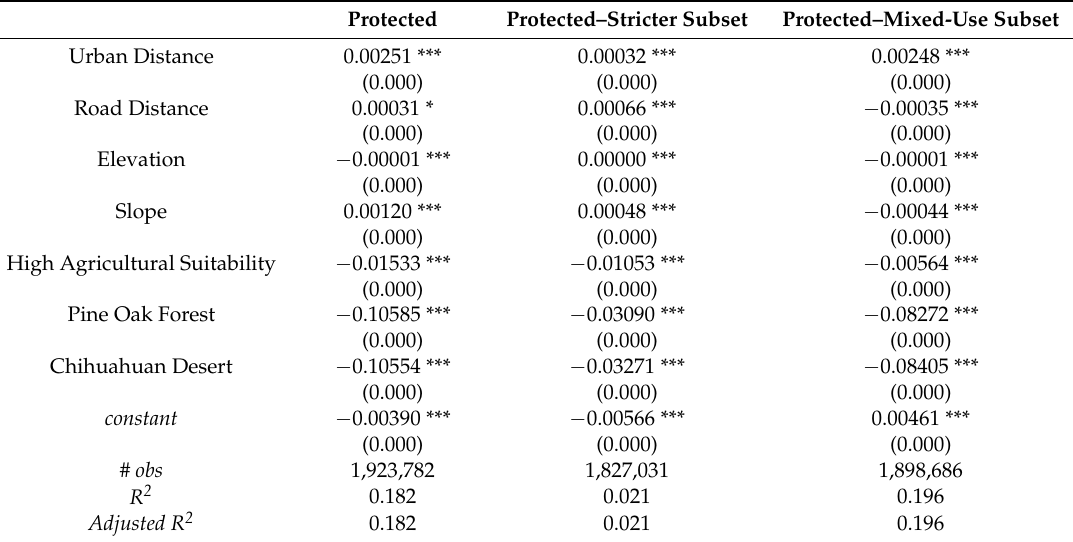
Table 2. Drivers of protection (including by type).